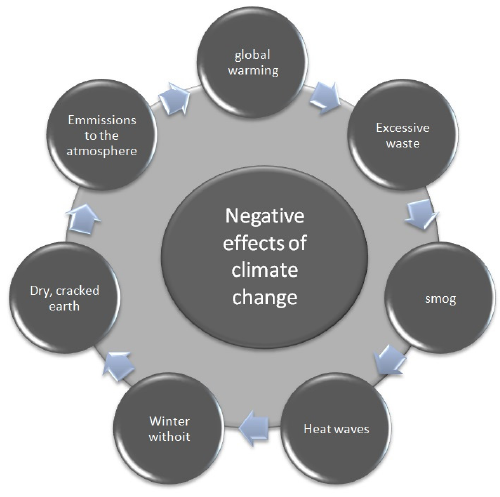
Figure 6. Effects of negative climate changes [52,53].